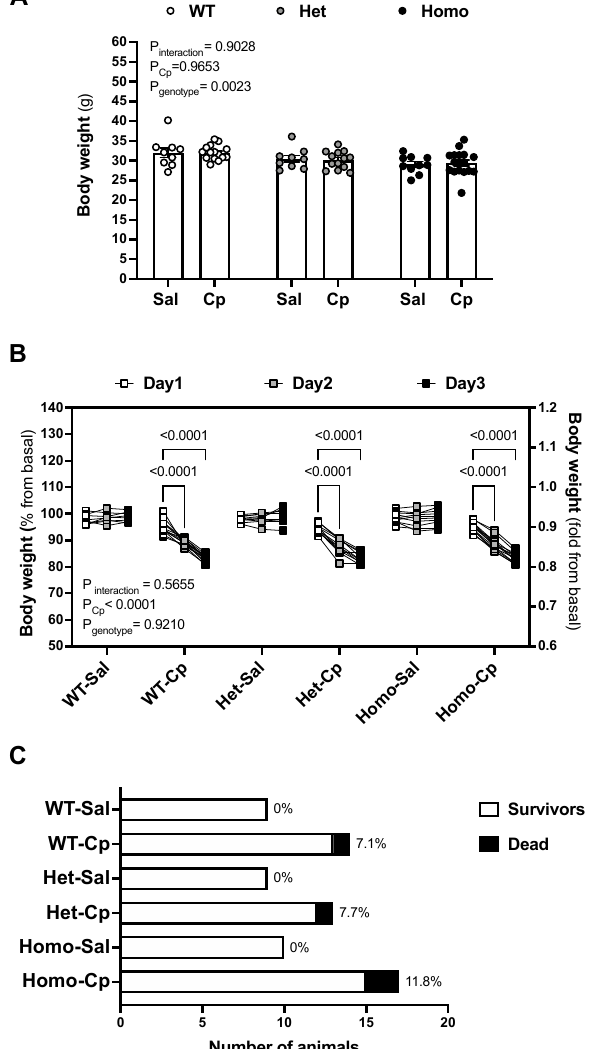
Figure 1. Cisplatin-induced body weight loss and mortality rate. Basal body weight on day 0 ( A ) and percentage change in body weight, relative to basal (day 0) values, on days 1–3 after cisplatin (Cp) or saline injections ( B ) were measured in male mice, homozygous (homo) and heterozygous (het) knockout for GPER1 gene, and wild-type (WT) littermates. The number of animals (WT, het, and homo) that survived or died in response to Cp or saline injections ( C ) was recorded during the first 3 days after the injections. Mice were injected with Cp (20 mg/kg) or saline on day 0. Data are presented as mean ± SEM (n = 9–17 mice/group). Statistical comparisons were performed by two-way ANOVA ( A ) or repeated measures two-way ANOVA ( B ) with Sidak’s post hoc test for multiple comparisons. p values for ANOVA and post hoc test results are displayed on the figures. For the three-way ANOVA, only p < 0.05 is displayed for clarity. Cp, cisplatin; Het: heterozygous knockout for GPER1 gene; Homo, homozygous knockout for GPER1 gene; Sal, saline; WT,